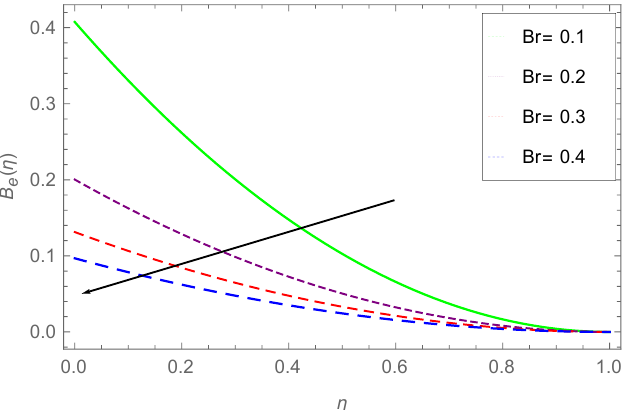
Figure 18. Deviations in Bejan number B e for dissimilar numbers of M , when Br = 0.1, R e = 0.7, Rd = 0.6, and Pr = 0.6.